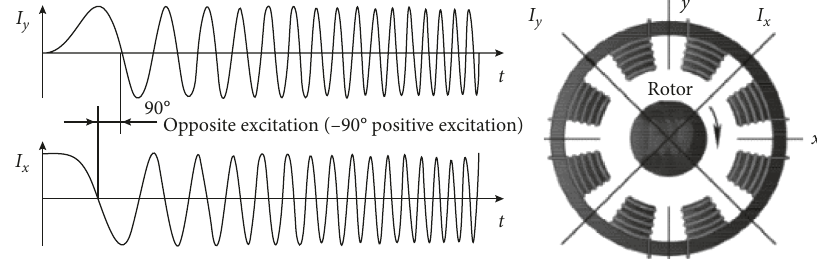
Figure 9: Current signal of electromagnetic bearing